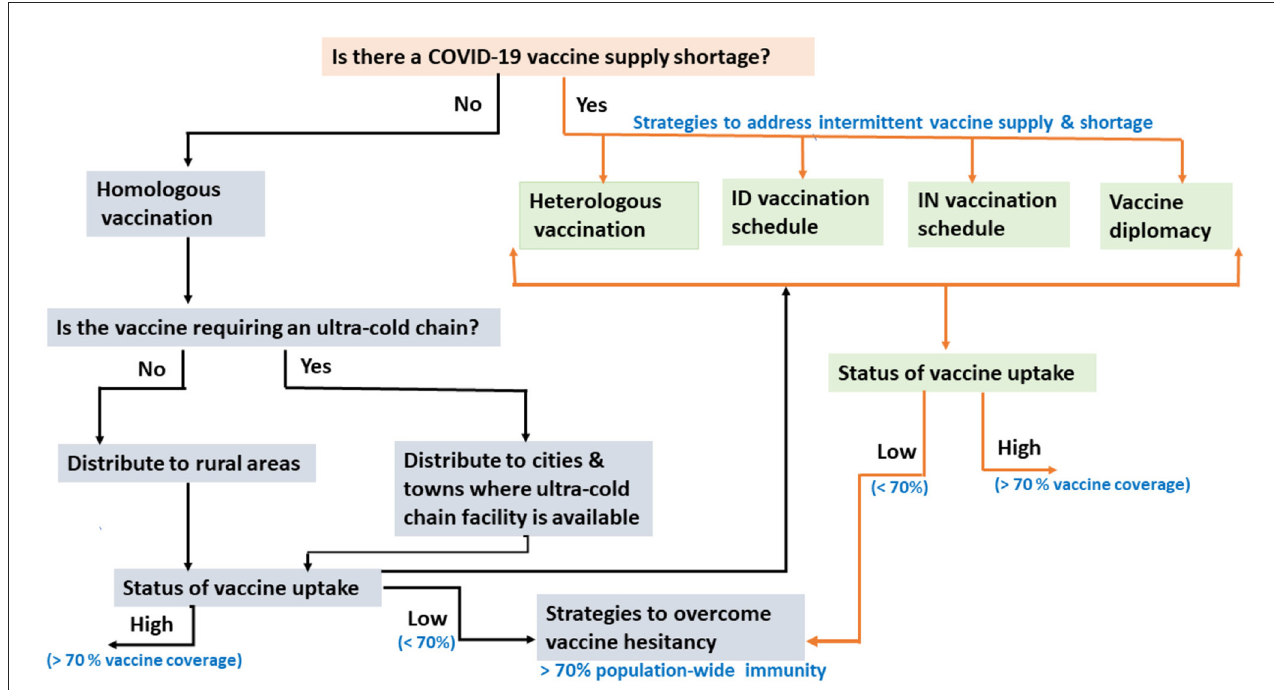
FIGURE1 Flow chart showing the challenges of COVID-19 vaccination rollout in Ethiopia, with possible mitigation strategies. ID, Intradermal; IN,